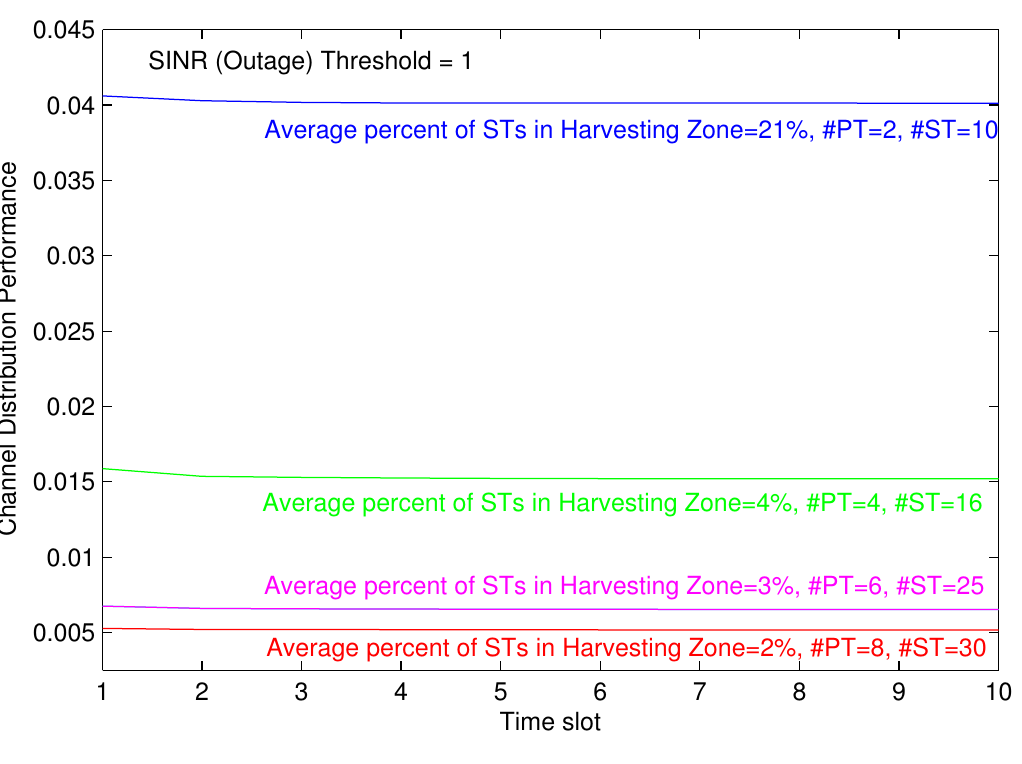
Figure 9. ChDistFairness against time slots for different percentages of STs in the harvesting zone for constant SINR (Outage) threshold of